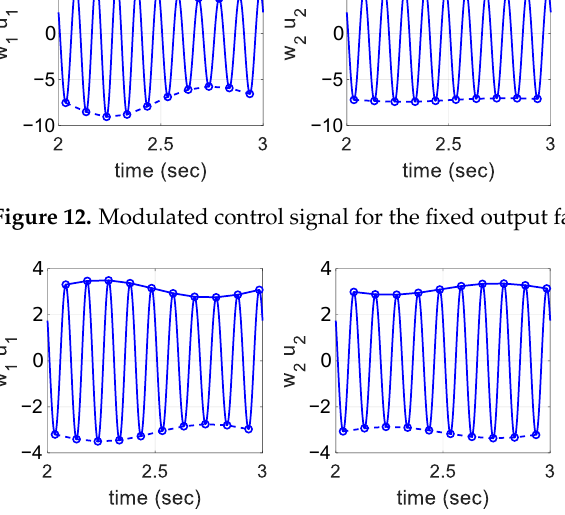
Figure 13. Modulated control signal for the scaled-down fault mode ( α = 0.7). Table 2. Modulated control signals and pattern variations when Motor 1 is faulty.